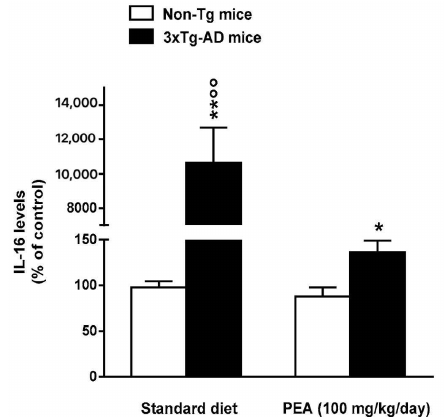
Figure 3. Effects of oral ultramicronized palmitoylethanolamide (um-PEA) treatment on interleukin 16 (IL-16) levels in the hippocampus of non-Tg and 3×Tg-AD mice. Age-matched non-Tg mice and 3×Tg-AD mice (2 months ± 2 weeks of age) have been orally treated for 3 months with the compound (100 mg/kg/day, added to the animal food), while control animals were fed with a standard diet during the treatment period. Biochemical analyses were performed on hippocampus tissues taken from mouse brains at the end of the treatment period. The data are expressed as percentage ± SEM of control (standard diet fed non-Tg mice) ( n = 4, in triplicate). * p < 0.05, ** p < 0.01 significantly different from the respective non-Tg mouse group; p < 0.01 significantly different from the respective PEA-treated group according to two-way ANOVA followed by Tukey multiple-comparison test.